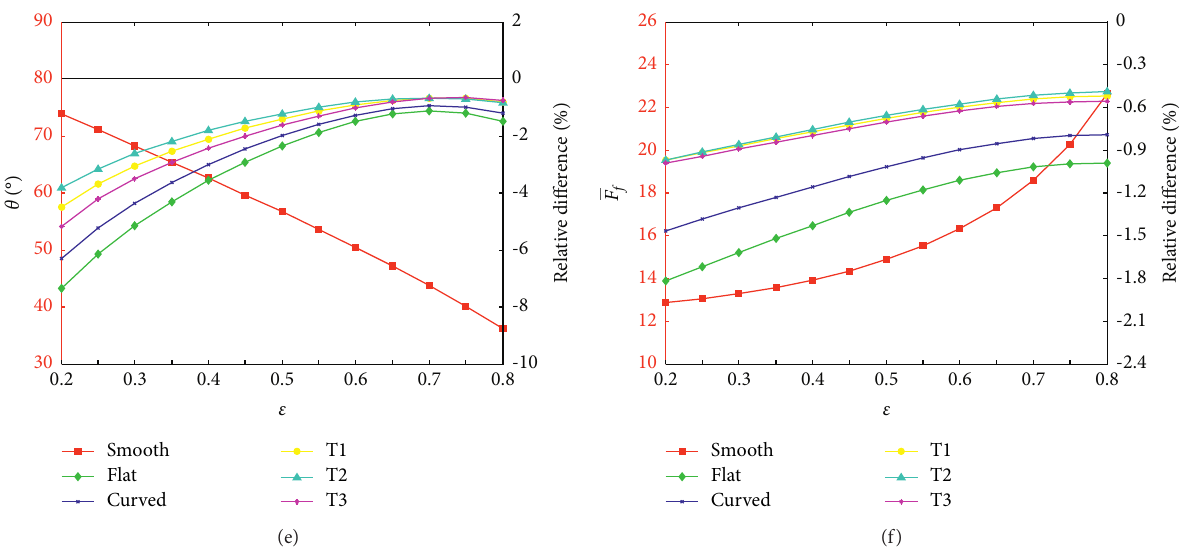
Figure 9: Effect of the eccentricity ratio on static performance characteristics for smooth/textured journal bearings: (a) the load-carrying capacity ( W ); (b) the maximum fluid film pressure ( P ); (c) the friction coefficient ( f ); (d) the end leakage flow rate ( Q Z ); (e) the attitude max angle ( θ ); (f) the friction force ( F f